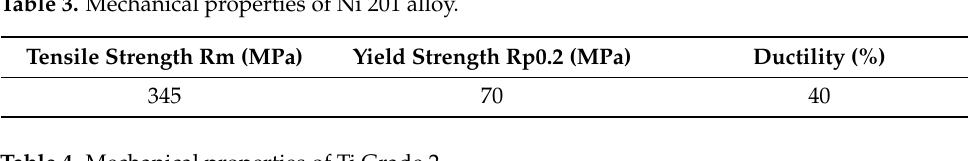
Table 3. Mechanical properties of Ni 201 alloy.